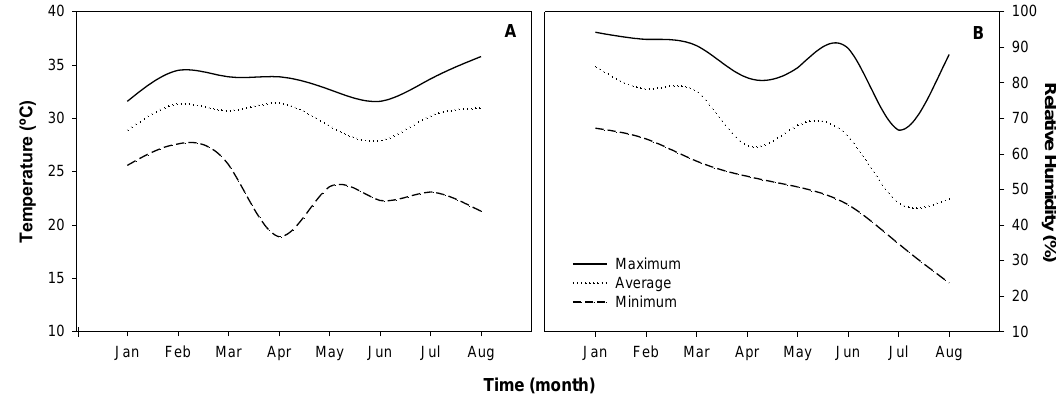
Figure 8. Glasshouse temperature (°C) and relative humidity (%) conditions during the experimental period. Temperature (°C) maximum, medium, and minimum ( A ); and relative humidity (%) maximum, medium, and minimum ( B ) in the glasshouse during the experimental period.